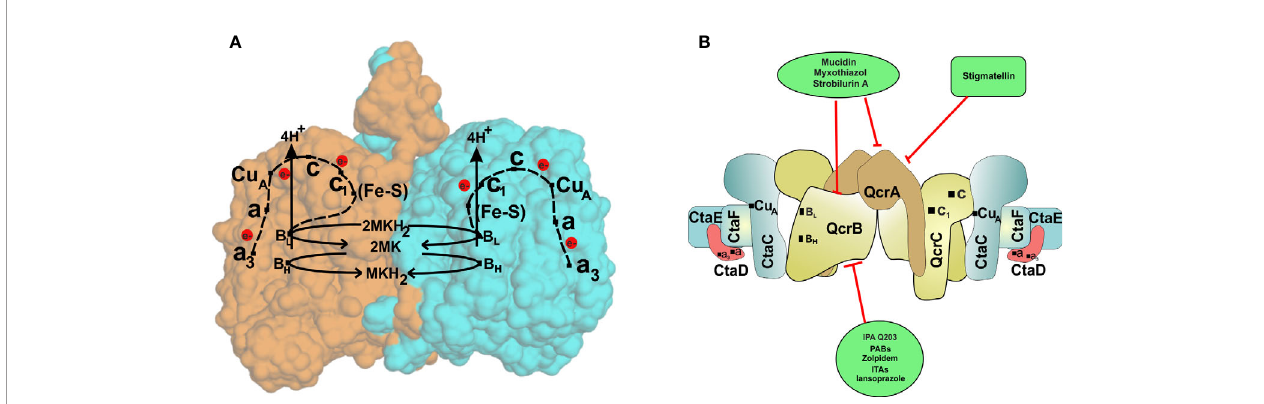
FIGURE 2 | The cytochrome bc 1 -aa 3 oxidoreductase supercomplex. (A) The passage of electron through various components of the cytochrome bc 1 -aa 3 oxidoreductase. The crystal structure of cytochrome bc 1 -aa 3 complex reveals its homo dimeric form. Each of the monomers is represented by a different color (orange and blue). The complex III is composed of a [2Fe-2S] cluster present on the Riske protein (QcrA), a cytochrome b (QcrB) containing two b- type heme groups (low and high potential), and a di-heme c- type cytochrome c 1 (QcrC). Electrons are initially accepted by the QcrB subunit, which is transferred to the Fe-S complex in QcrA, releasing proton in the periplasmic space. Electrons are then passed to cytochrome c of the QcrC subunit via cytochrome c 1 . CuA (located on CtaC, subunit II) harvests electrons from the cytochrome c and transfers them to heme a (located on CtaS, subunit I), which then passes them to the dinuclear site composed of heme a3 and CuB (located on CtaD). The dinuclear site activates oxygen for reduction and rapid transfer of four electrons converting it to water. (B) Schematic representation of cytochrome bc 1 -aa 3 subunits and their inhibitors. Cytochrome bc 1 -aa 3 forms complex III and IV of the ETC of Mycobacterium species and has proved to be novel drug target against the